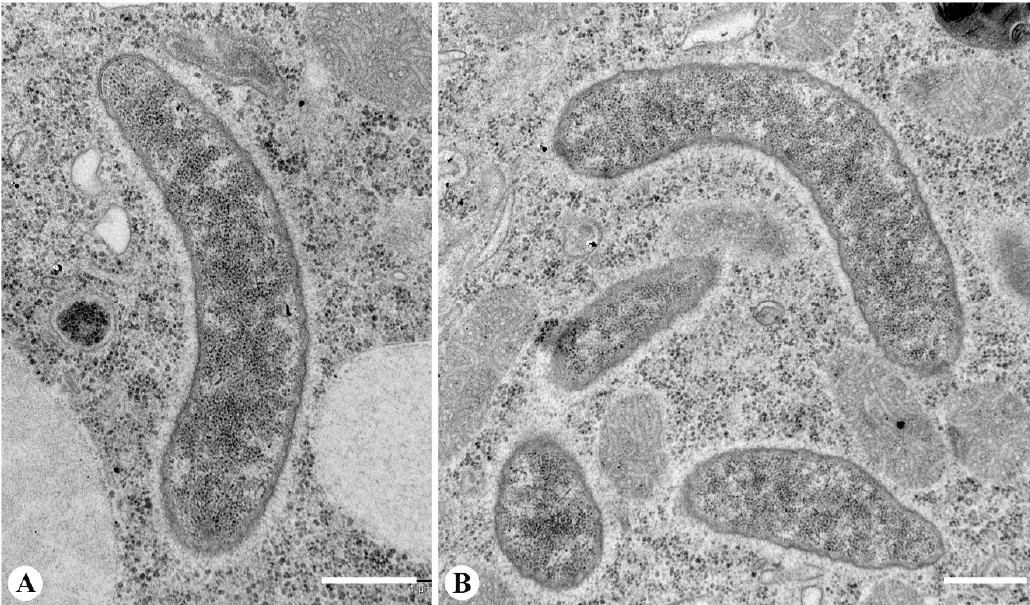
Figure 2. Transmission electron microscopy images of CS-bacteria in the cytoplasm of P. nephridiatum strain BMS16-23. ( A ) The bacterium in the cytoplasm. ( B ) A fragment of a putative conglomeration with the host mitochondria. Scale bar 500 nm.